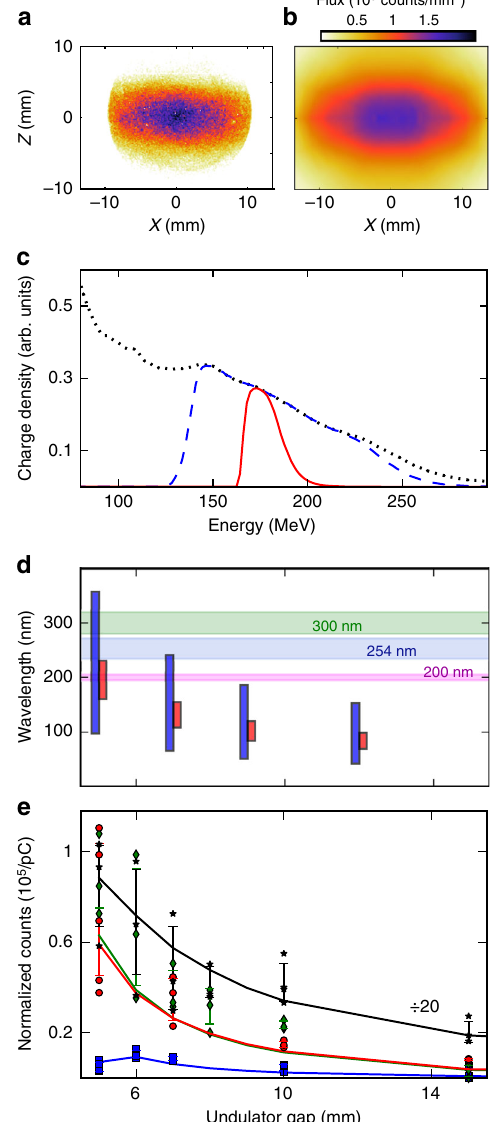
Fig. 7 Observation of undulator radiation. Measurement ( a ) and numerical modelling ( b ) of the radiation fl ux density normalised to 1 pC (without slit, bandpass fi lters and focusing lens). c Spectrum measured at the exit of the electron source (dotted), and simulated at the entrance of the undulator after transport in the line (dashed), with the 4 mm slit (solid curve). d On- axis resonant wavelength ranges without (blue) and with (red) slit, with electrons below 10% of the maximum charge excluded and spectral FWHM bandwidth of the optical fi lters. e Total photon count measured by a camera with a lens and normalised by the beam charge black stars: without slit and bandpass fi lter, downscaled by a factor 10; with a 4 mm slit, red circles: 300 nm, green diamonds: 253 nm, blue squares: 200 nm fi lter. Error bars: mean values and deviations of acquired data sets, solid curves: numerical